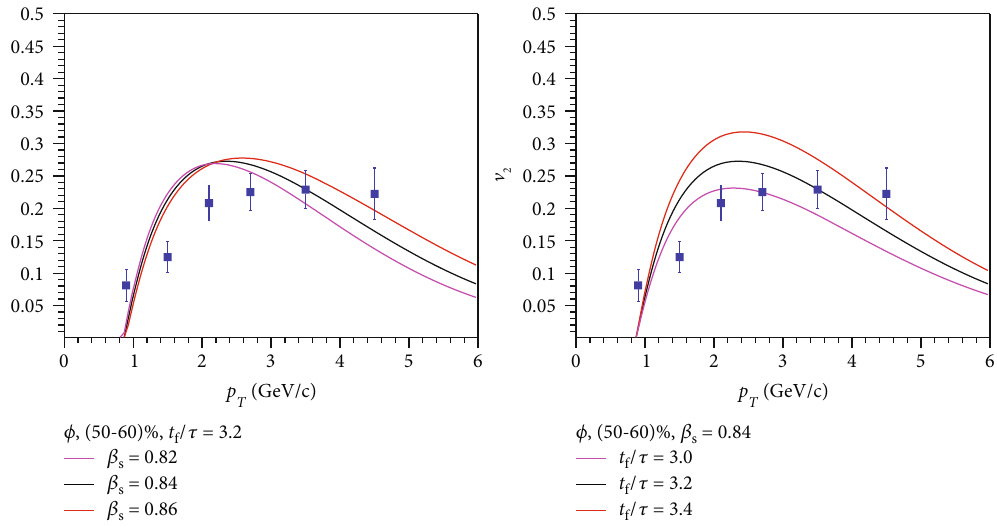
p ffiffiffiffiffiffiffiffi = 2 : 76TeV . s NN